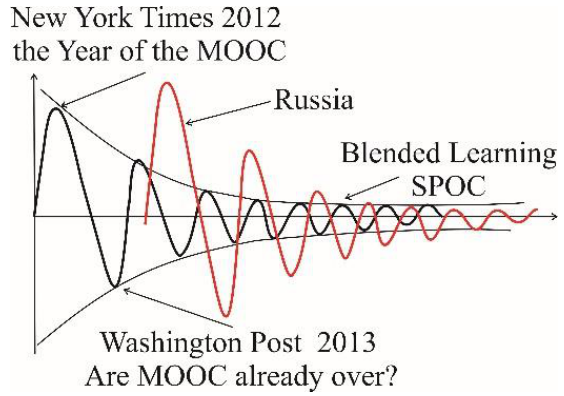
Fig. 3 . The cycle of online courses